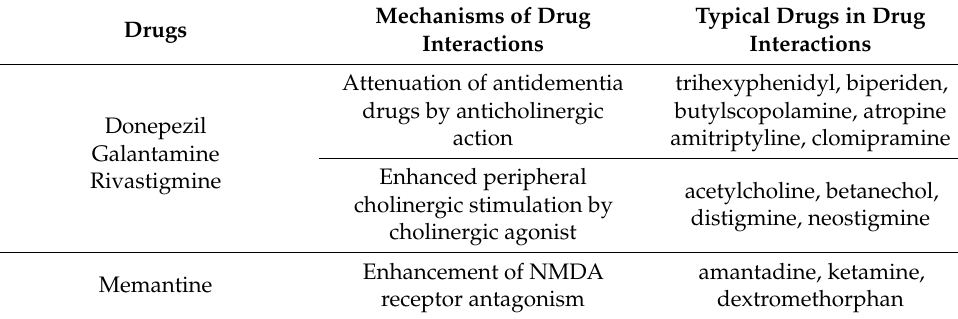
Table 2. Pharmacodynamic Drug Interaction in Alzheimer’s